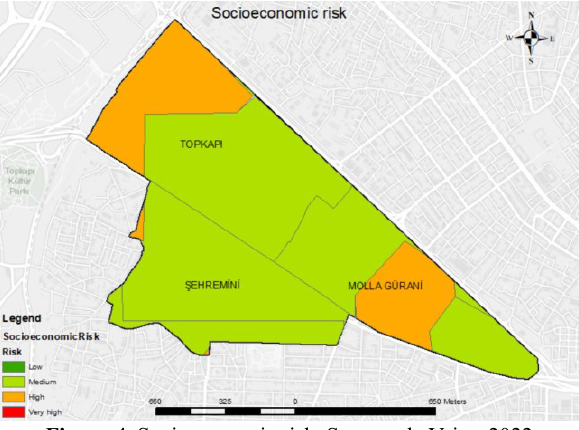
Figure 4 . Socioeconomic risk. Source: de Vries, 2022